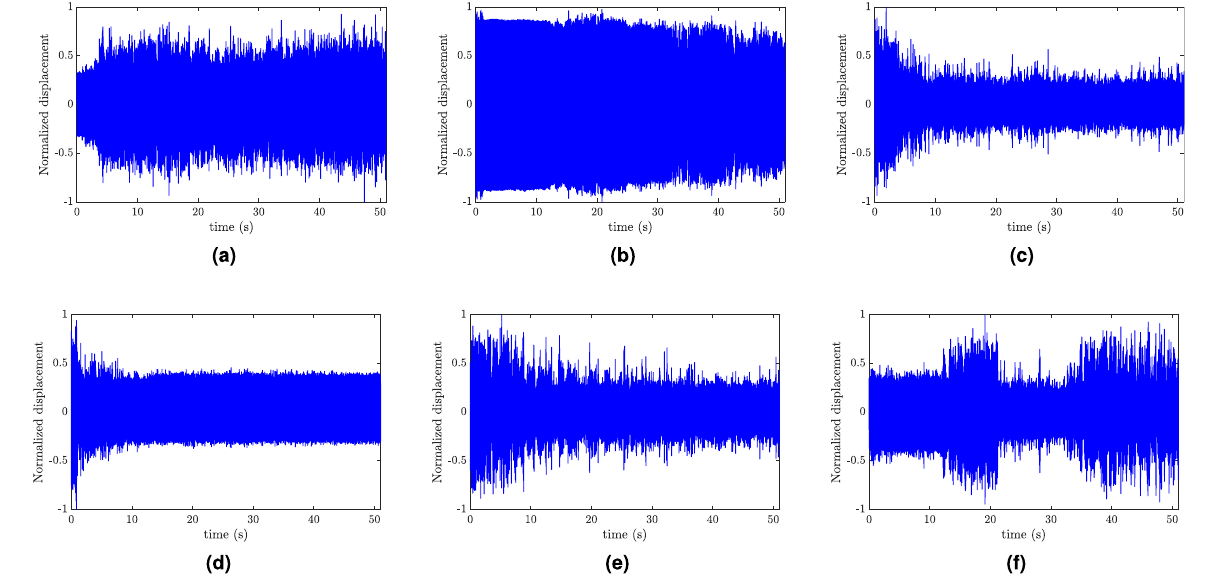
Figure 10. Test measurement of the tip displacement: ( a ) f = 230 Hz, s start = 0.8 a r , s end = 0.9 a r , w 0 = 6 g ; ( b ) f = 145 Hz, s start = 0.74 a r , s end = 0.86 a r , w 0 = 0.6 g ; ( c ) f = 100 Hz, s start = a r , s end = 0.8 a r , w 0 = 1.37 g ; ( d ) f = 70 Hz, s start = 82 a r , s end = 0.66 a r , w 0 = 1.44 g ; ( e ) f = 60 Hz, s start = 0.77 a r , s end = 0.52 a r , w 0 = 1 g ; ( f ) f = 55 Hz, s start = 0.77 a r , s end = 0.6 a r , w 0 = 1 g